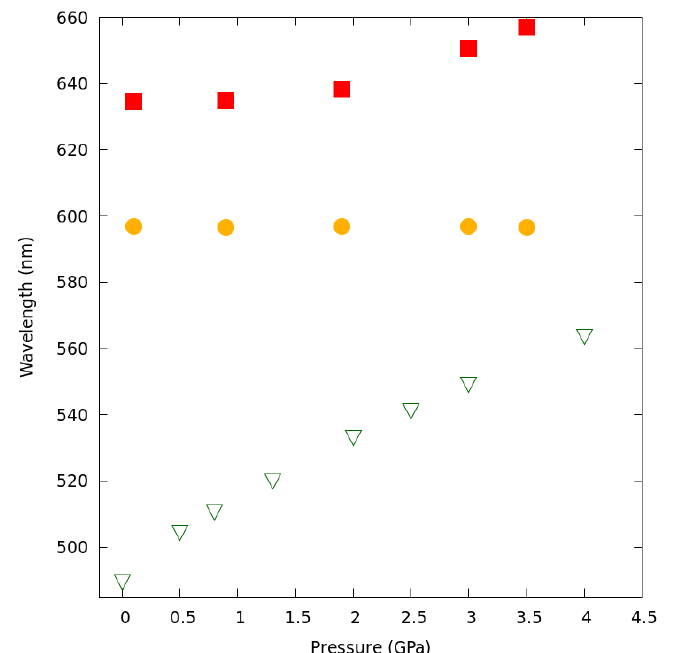
Figure 10. The variation of the theoretically-predicted wavelength of maximum absorption (green triangles), experimentally-observed λ emission max attributed to small aggregates (the orange band represented as orange circles), and the experimentally-observed λ emission max attributed to larger aggregates or multimers (the red band represented as red squares). The latter shows small variation with pressure above 2.0